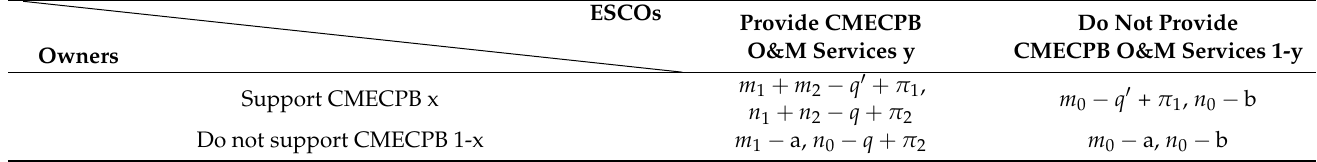
Table 3. The game payoff matrix between owners and ESCOs with the introduction of